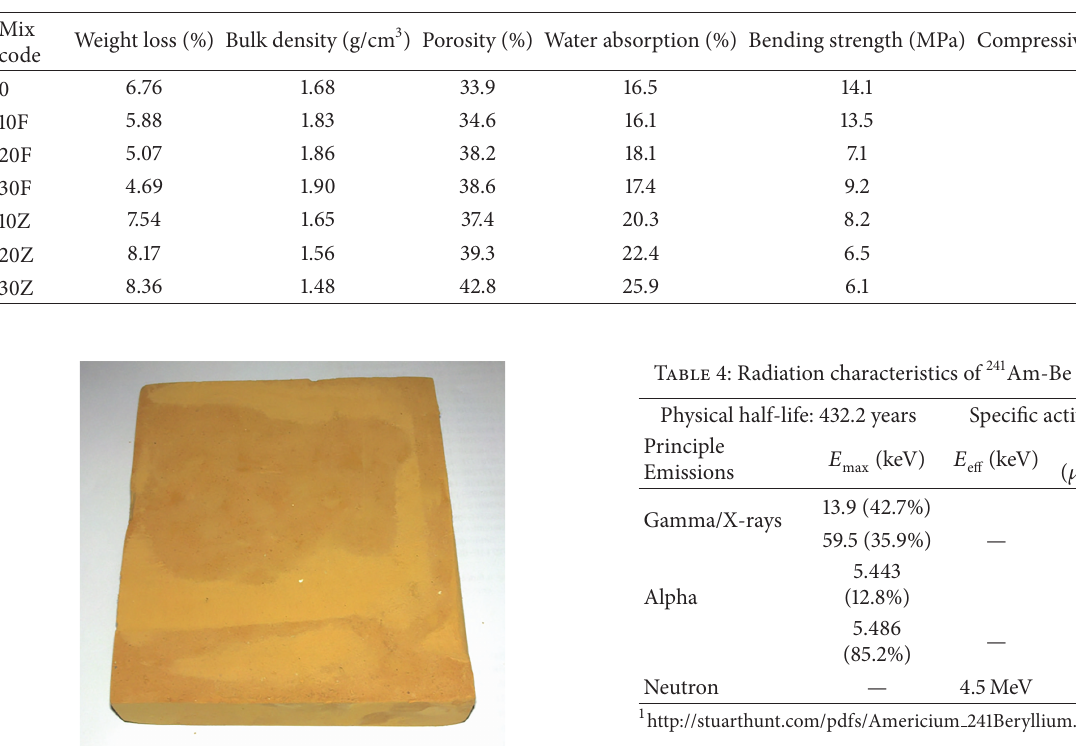
Table 3: Experimental results of the brick samples fired at 900 ∘ C.